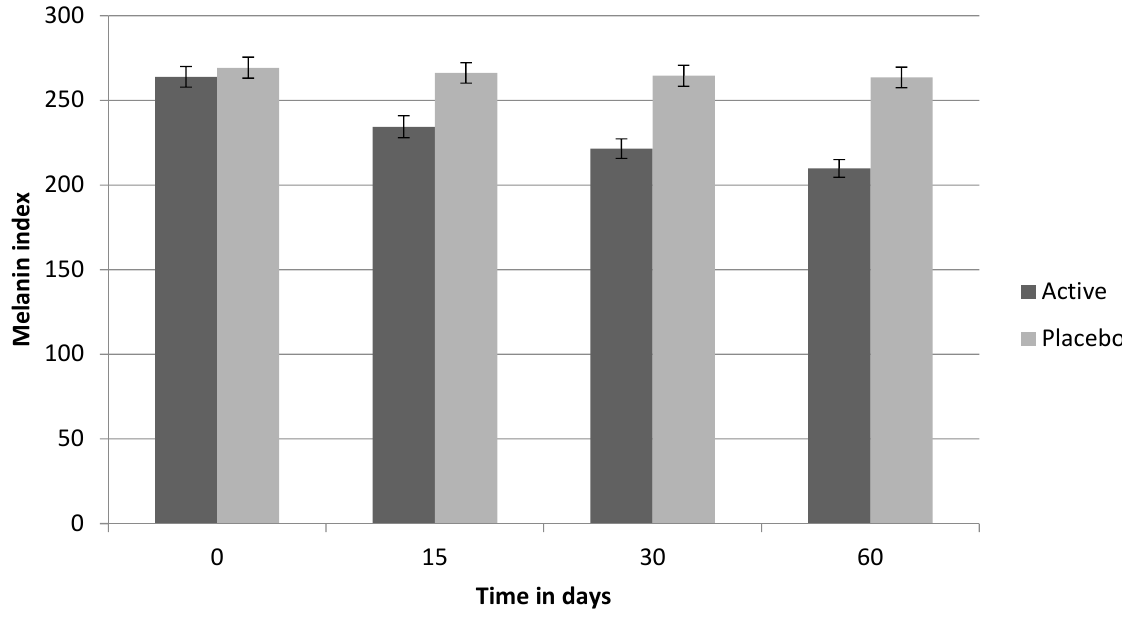
Figure 2. Clinical test on Fucus vesiculosus extract: age spot intensity over time.